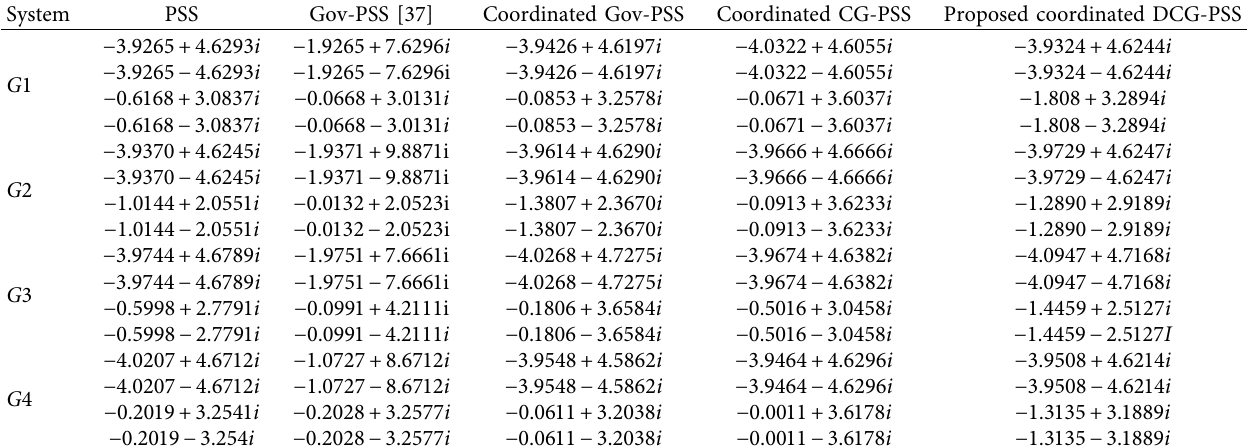
Table 5: Mechanical mode for local oscillations.